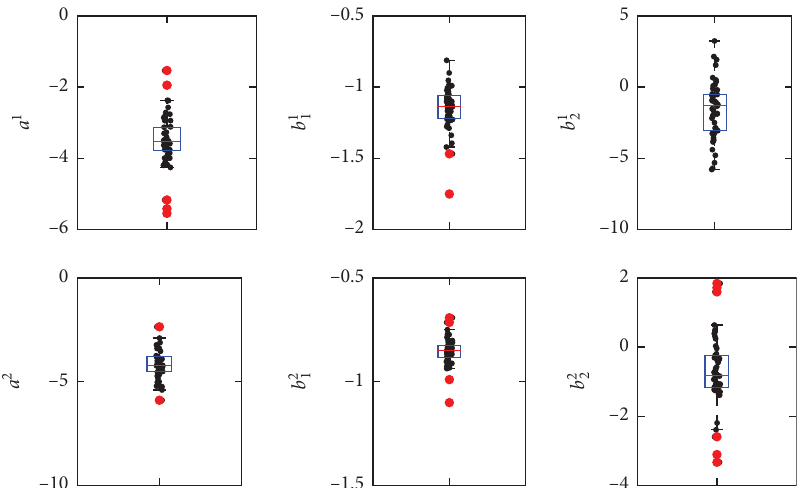
2 particles using